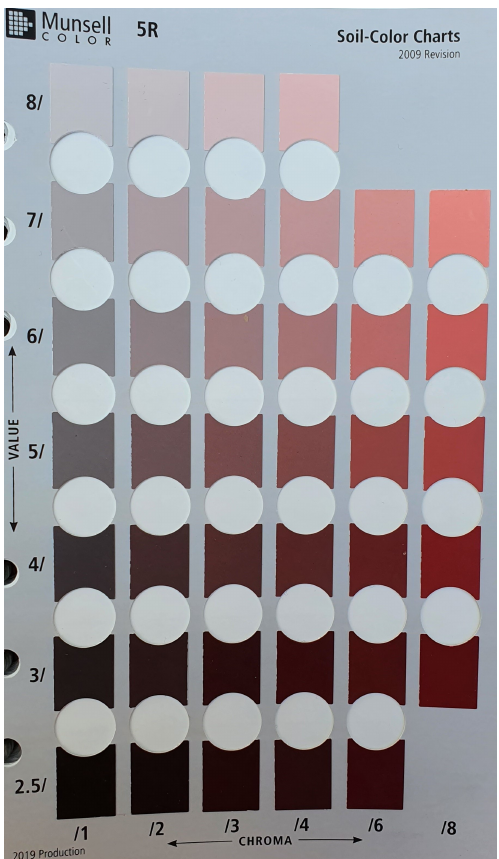
Figure 2. Example of the 5R card of Munsell Soil Colour Book.